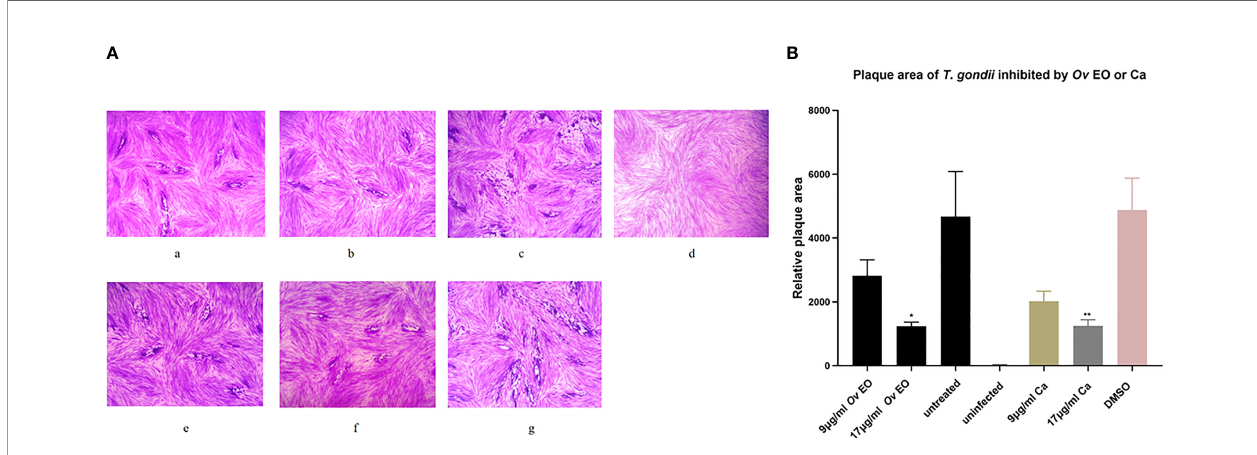
FIGURE 2 | Plaque test for preliminary detection of anti- T. gondii activity of Ov EO and Ca. (A) Images of T. gondii plaque under different concentrations of Ov EO and Ca. (B) Statistical analysis of the images plaque. (a) HFF cells were infected by T. gondii and treated with 9 m g/ml Ov EO; (b) HFF cells were infected by T. gondii and treated with 17 m g/ml Ov EO; (c) HFF cells were infected by T. gondii and untreated; (d) HFF cells were not infected and treated; (e) HFF cells were infected by T. gondii and treated with 9 m g/ml Ca; (f) HFF cells were infected by T. gondii and treated with 17 m g/ml Ca; (g) HFF cells were infected by T. gondii and treated with 1.56% DMSO.